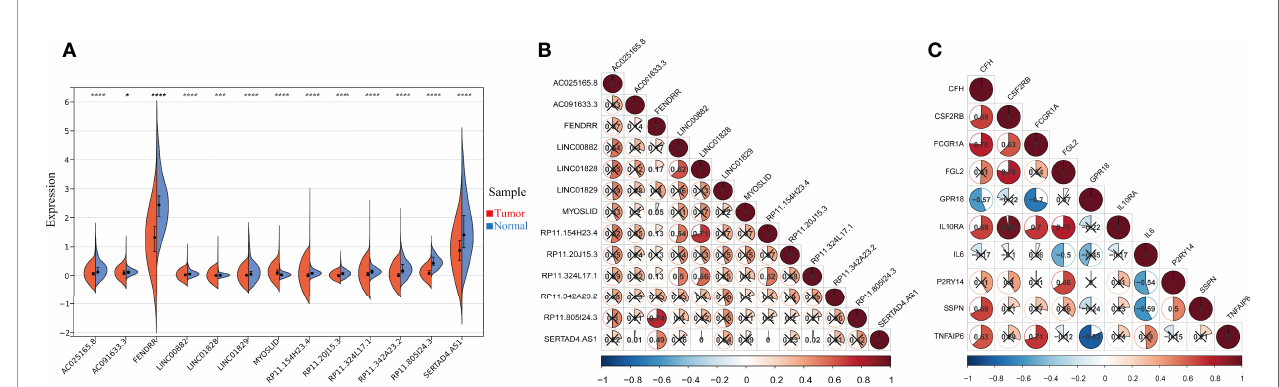
FIGURE 2 | The expression and correlation among IFN- g -related lncRNAs. (A) Violin plot of the expression levels of 13 IFN- g -related lncRNAs between tumour and normal samples. (* p < 0.05; *** p < 0.001; **** p < 0.0001). (B) The correlation of 13 differently expressed IFN- g -related lncRNAs from the TCGA COAD cohort. (C) The correlation among 10 differently expressed IFN- g